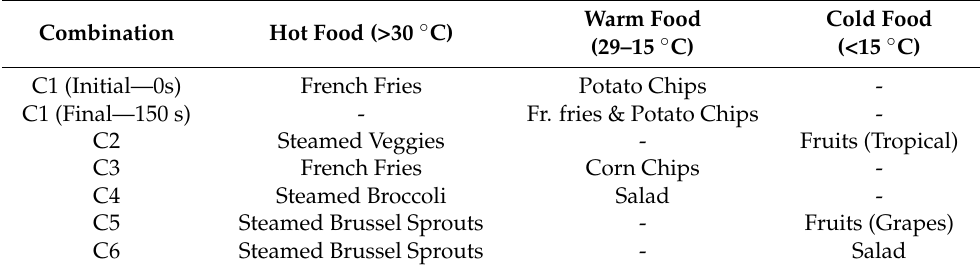
Table 1. Dataset: 6 Combinations of Food Items.